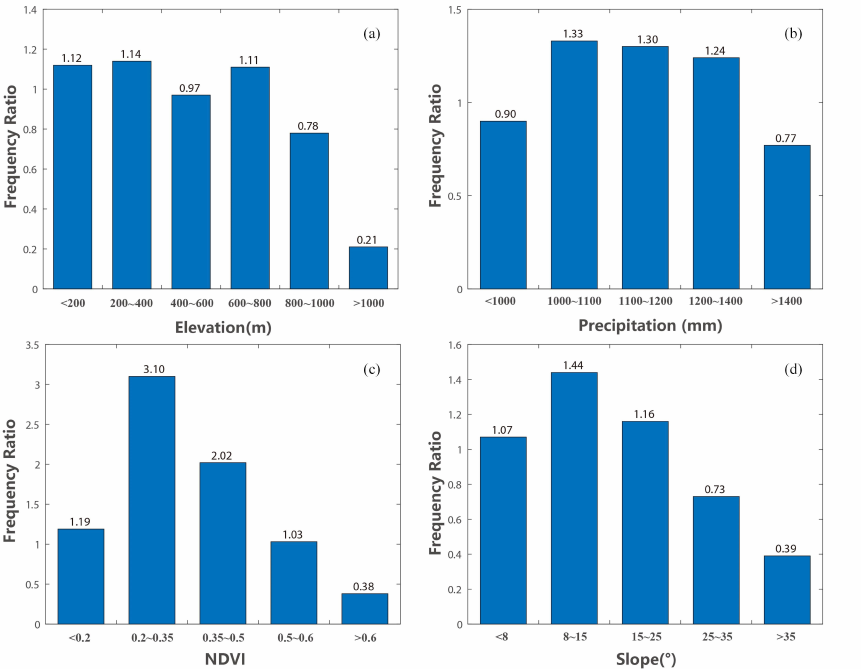
Figure 11. Frequency ratios of typical conditioning factors: ( a ) NDVI; ( b ) precipitation; ( c ) evaluation; ( d ) slope at different